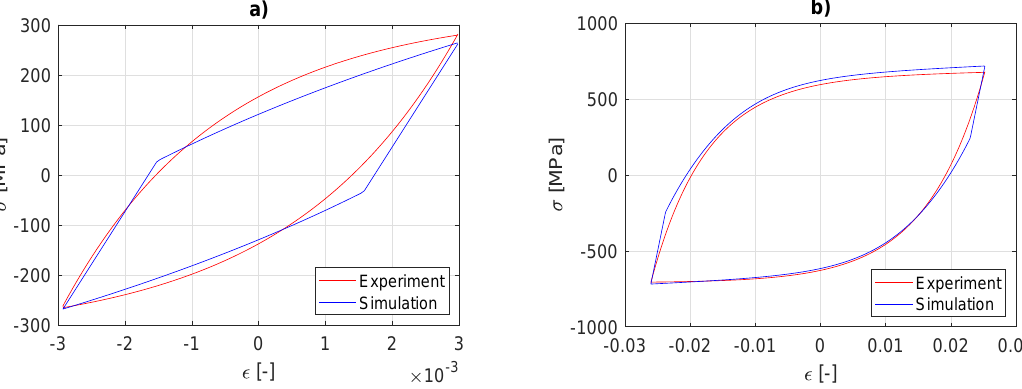
Figure 12. Chaboche coefficients fitting: ( a ) small loop; ( b ) large loop.